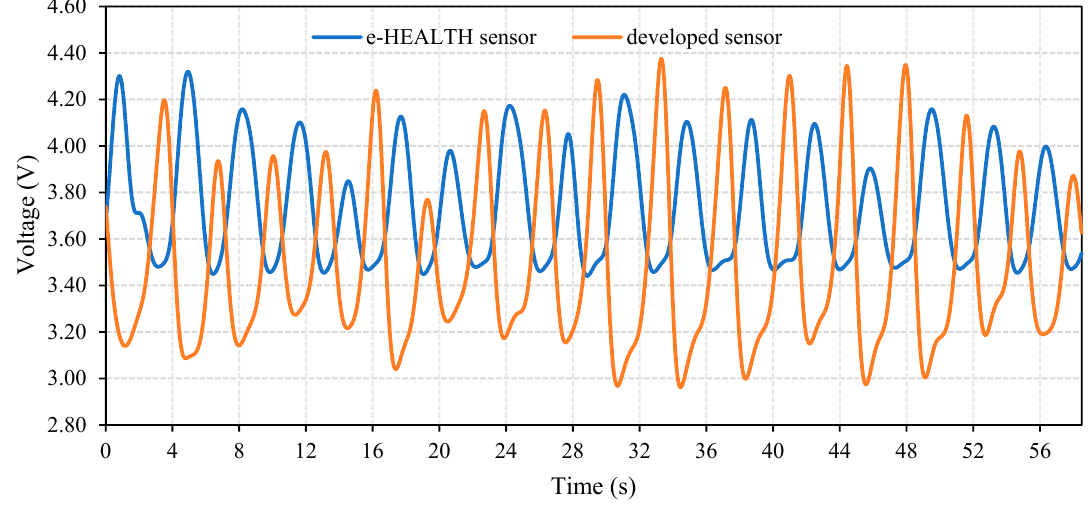
Figure 14. The respiratory signals derived by the developed IJP PDMS-based sensor and reference e-Health sensor. Signals were derived from subject 6 in Table A1 in the sitting position.